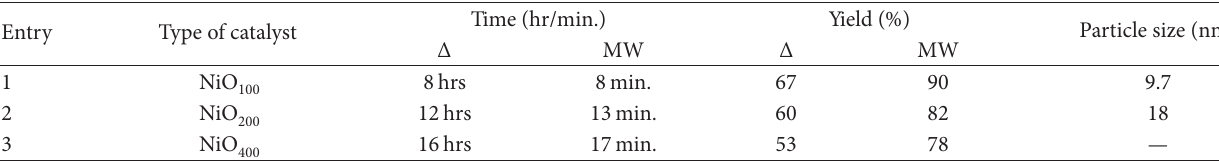
T 3: Comparison of catalytic activity of NiO nanoparticle calcined at 100 the compound 5a under conventional heating and microwave irradiation methods.